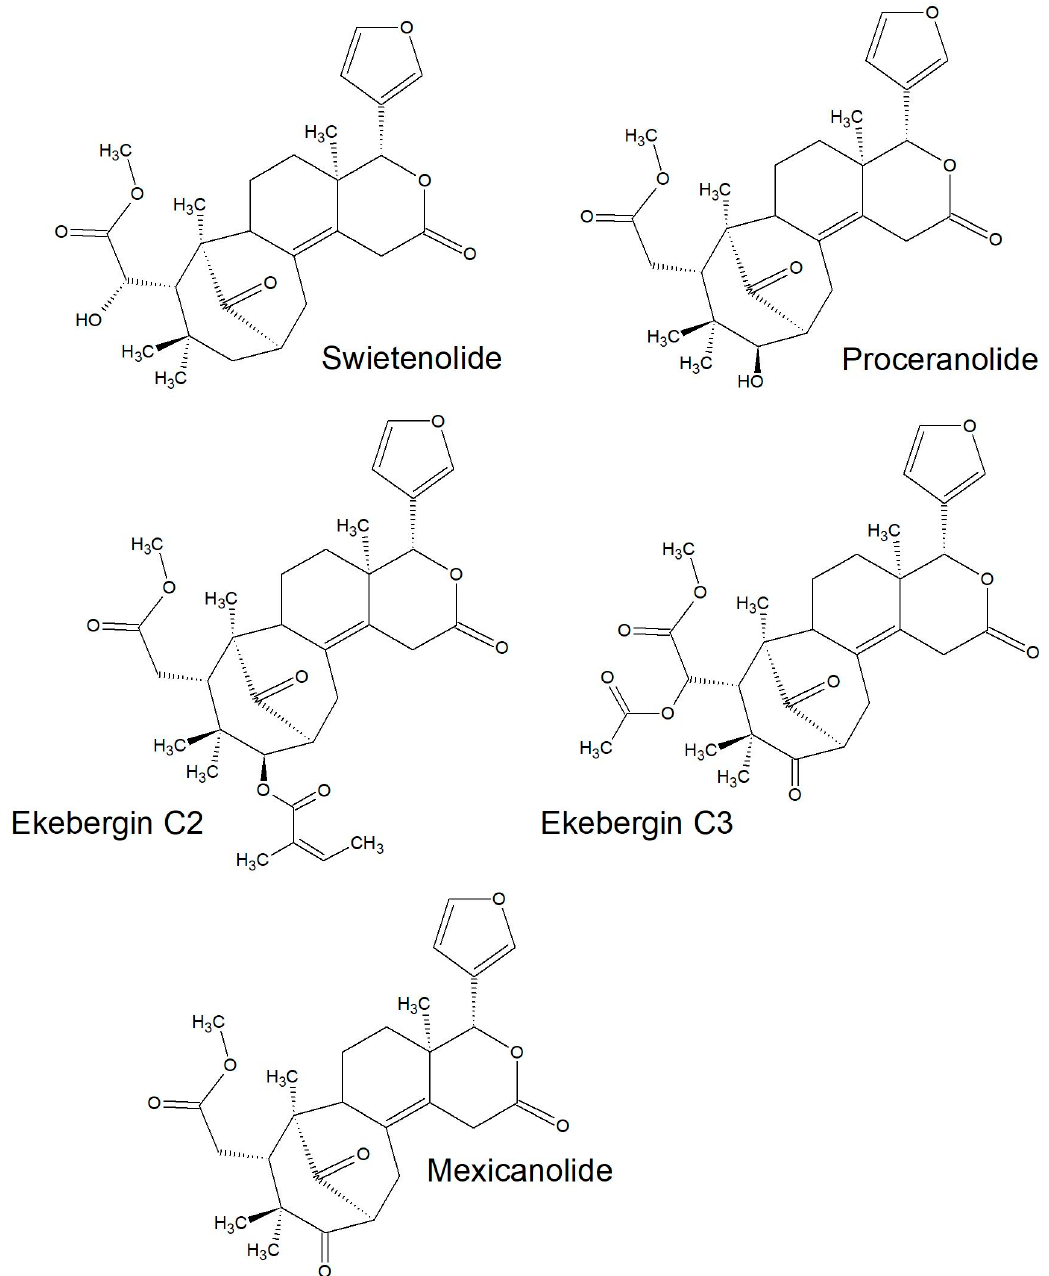
Figure 14. Swietenolide and Ekebergin series of limonoids reported from South African Meliaceae [31,33].